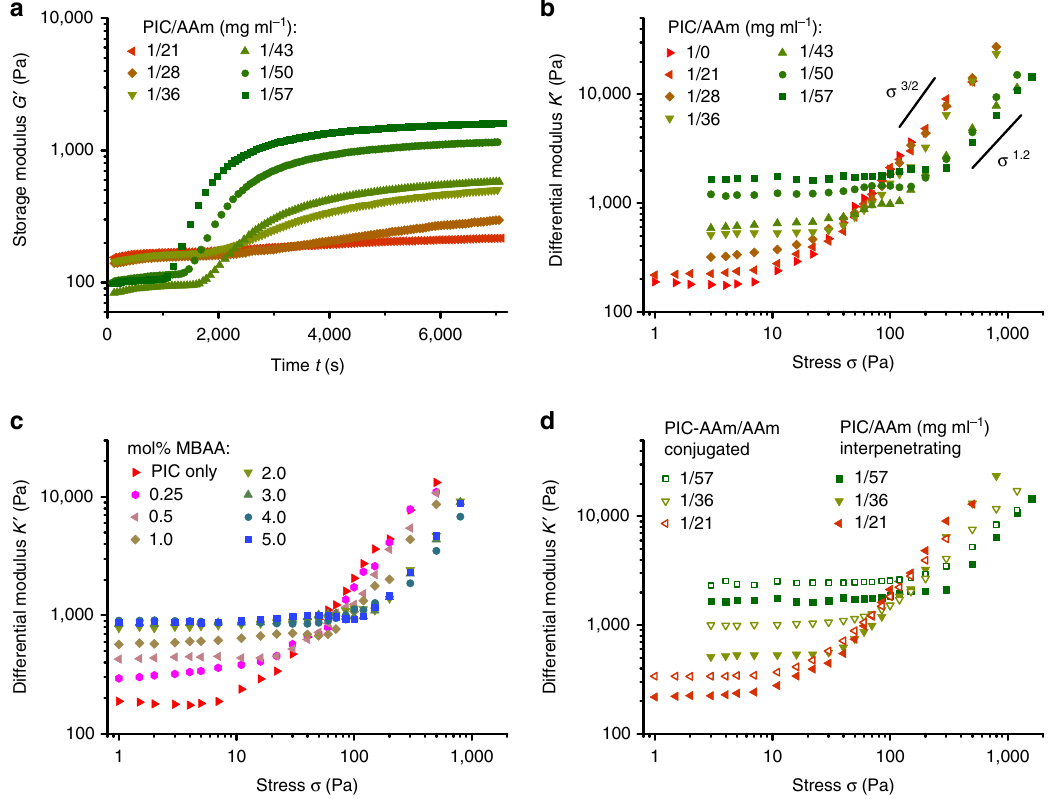
Figure 4 | Mechanical properties of composites with semi-flexible PIC networks and flexible PAAm networks. ( a ) Storage modulus G 0 as a function of time for PIC/PAAm hybrid hydrogels at T ¼ 50 (cid:2) C, showing the formation of the PAAm network within the pre-formed PIC network. De decrease in G 0 with increasing (AAm) is the result of the Hofmeister effect. ( b ) The differential modulus K 0 of the PIC/PAAm hybrid hydrogels increases with AAm concentration in the linear regime at low stress, but decreases with AAm concentration in the high-stress regime. The solid lines represent the slopes of the curves. ( c ) K 0 as a function of stress for PIC/PAAm hybrid hydrogels at T ¼ 50 (cid:2) C with 36mgml (cid:2) 1 (0.5M) AAm and increasing concentrations of crosslinker MBAA. ( d ) K 0 as a function of stress for conjugated (open symbols) and non-conjugated polymer networks (solid symbols, data from b ). NATURE COMMUNICATIONS|8:15478|DOI: